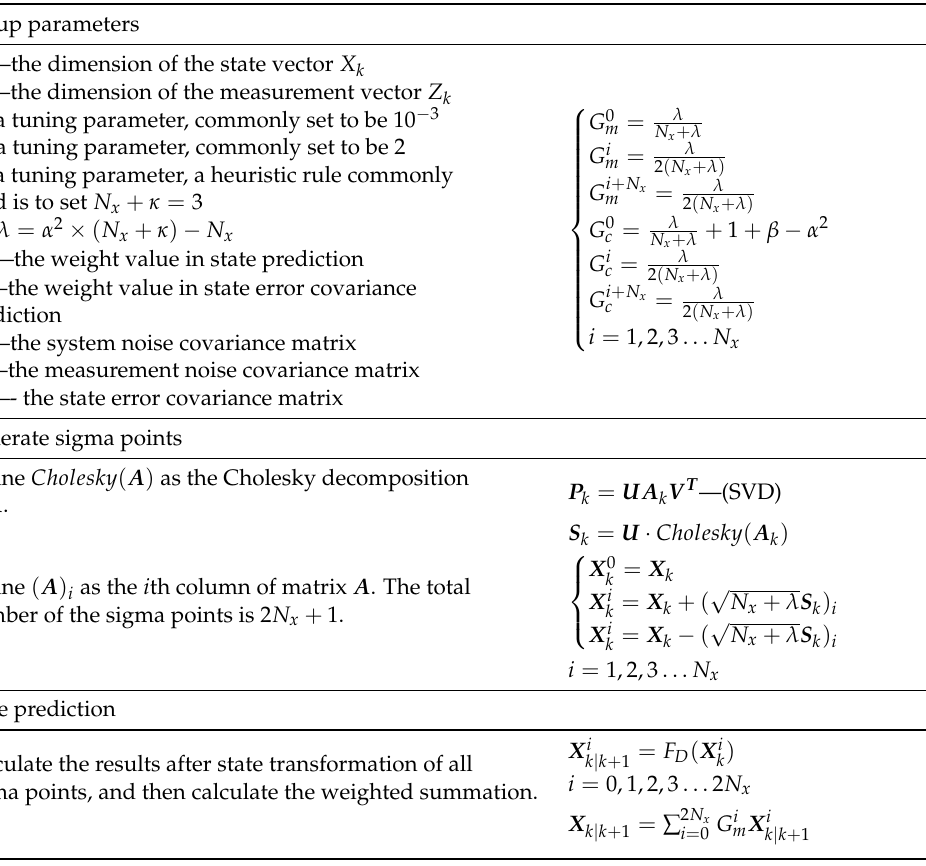
Table 2. The process of UKF in DOA/range